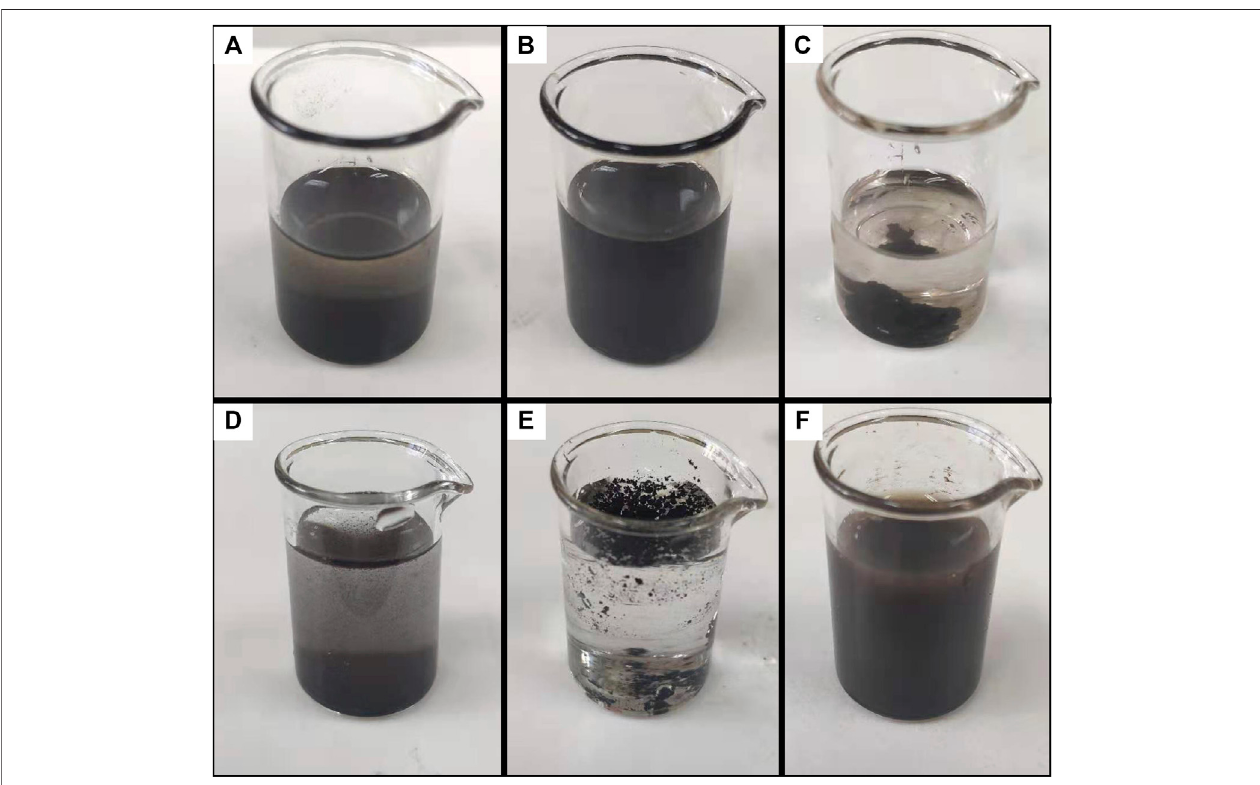
FIGURE 6 | Colloidal systems formed by magnetite particles coated by different surfactants in polar or apolar carrier liquid. (A) Uncoated particles in carbon tetrachloride. (B) OA-coatedparticlesincarbontetrachloride. (C) DP-coatedparticlesincarbontetrachloride. (D) Uncoatedparticlesinwater. (E) OA-coatedparticlesin water. (F) DP-coated particles in water.